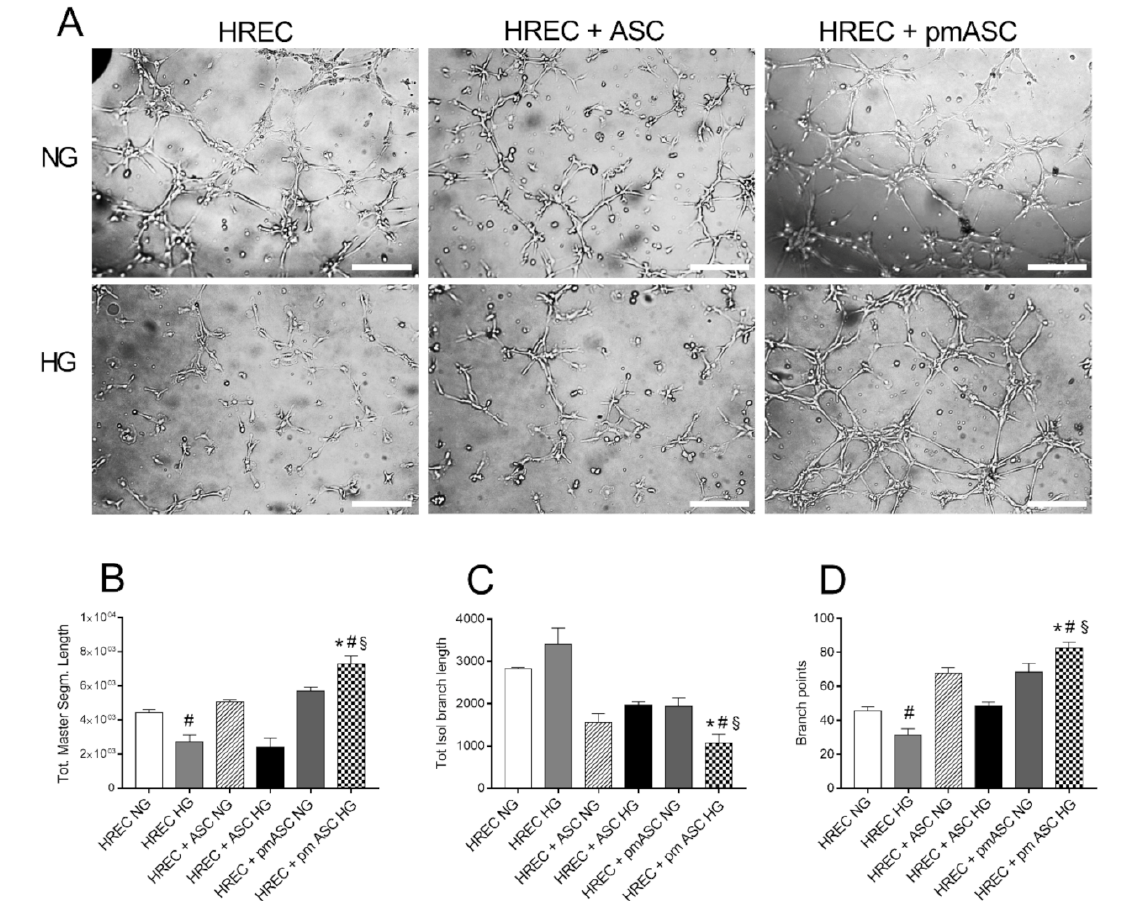
Figure 6. High glucose effects on tube-like structure formation by human retinal endothelial cells (HREC), or co-cultured with ASCs (HREC + ASC) or with pmASCs (HREC + pmASC). In some samples, glucose was added to the culture medium (High Glucose, 25 mM, HG) and compared to samples kept in normal glucose (NG) condition. ( A ), Representative microphotographs showing three-dimensional cultures in Matrigel of each sample. Pictures were taken at 6 h after seeding. Scale bar: 250 µ m (Magnification: 4 × ). Histograms at the bottom show the “total master segment length” ( B ), the “total isolated branch length” ( C ) and “branching points” ( D ). Quantitative analysis was carried out using Image J software. Values are expressed as a mean ± SEM of three independent experiments. * p < 0.05 pmASC vs. ASC; # p < 0.05 HG vs. NG; § p < 0.05 vs. HREC HG. Two-way ANOVA, followed by Sidak’s